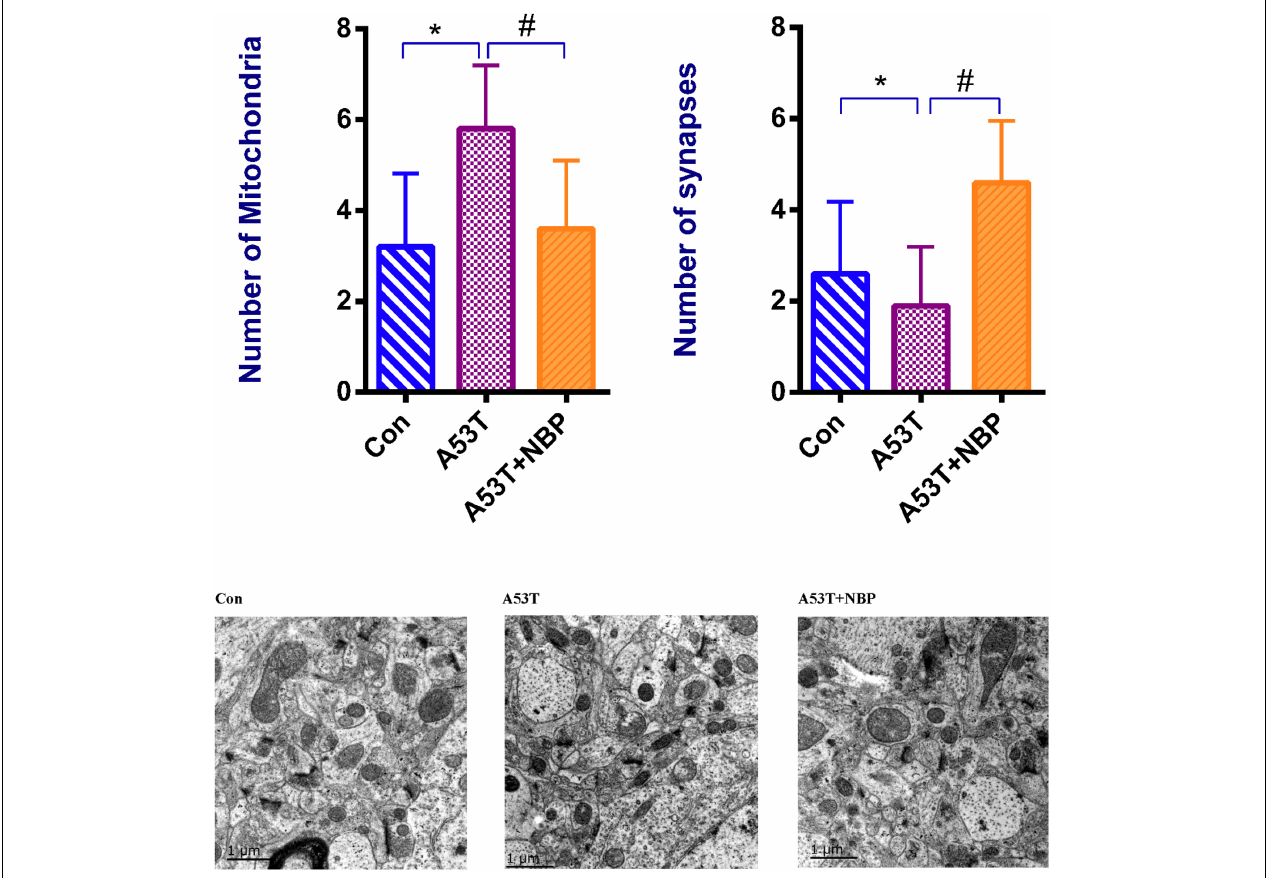
FIGURE 3 | Mitochondrial morphology. Visualization of mitochondrial structural features. When quantified, the number of mitochondria was increased, and the number of synapses was decreased significantly in the A53T group (* P < 0.05). After Dl-3-n-butylphthalide (NBP) application, the number of mitochondria was reduced, and the number of synapses was increased significantly ( # P < 0.05), while the mitochondrial structural features were partially recovered. All data were expressed as mean ±